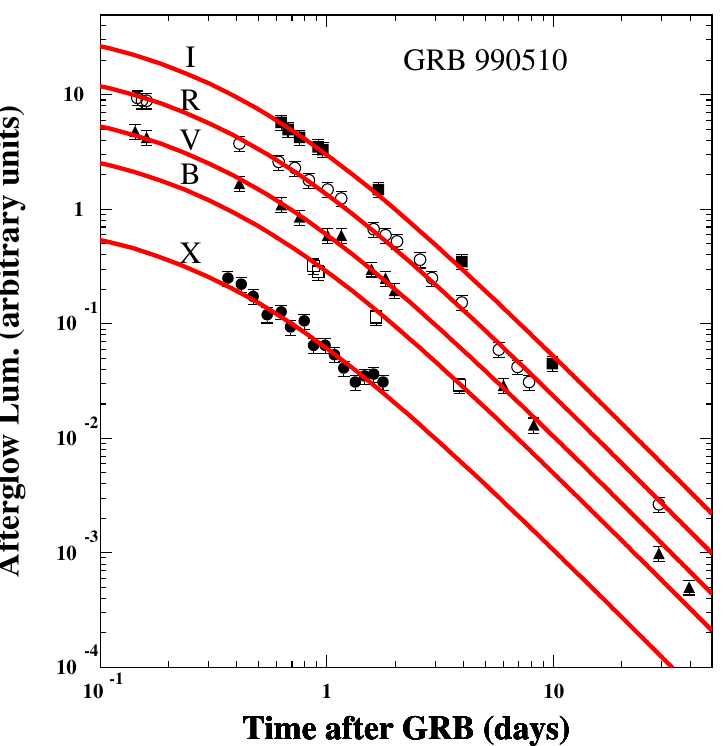
Figure 18. Comparison of Equation (19), the predicted temporal behavior of the light curves of the X-ray and optical AGs of GRB990510, with the observations. The X-ray data at 5 keV (filled circles) are from [112]. The data in the bands I (filled squares), R (empty circles), V (filled triangles) and B (open squares) are those compiled in [112] from [113–116]. The flux normalization is arbitrary. The AG of GRB 990510 and others which were fit by smoothly broken power laws are not conclusive evidence of conical jets. In fact, an isotropic radiation from a pul- sar wind nebula (PWN), powered by a newly born millisecond pulsar, has an expected luminosity [117] satisfying